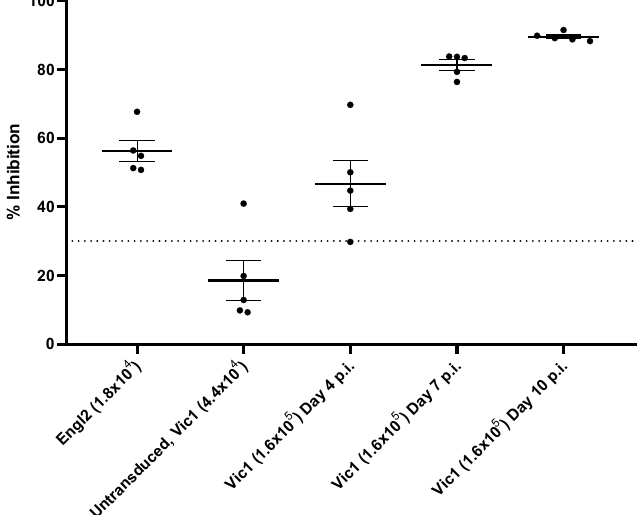
Figure 4. Infected mice developed an antibody response to RBD. Mouse serum samples taken at termination on days 4, 7 or 10 p.i. were tested for their ability to compete with wild-type RBD for binding to the ACE2 receptor. Dotted line represents the cut-off of the assay to define whether it is positive (>30%) or negative (<30%) according to the manufacturers’ instructions.